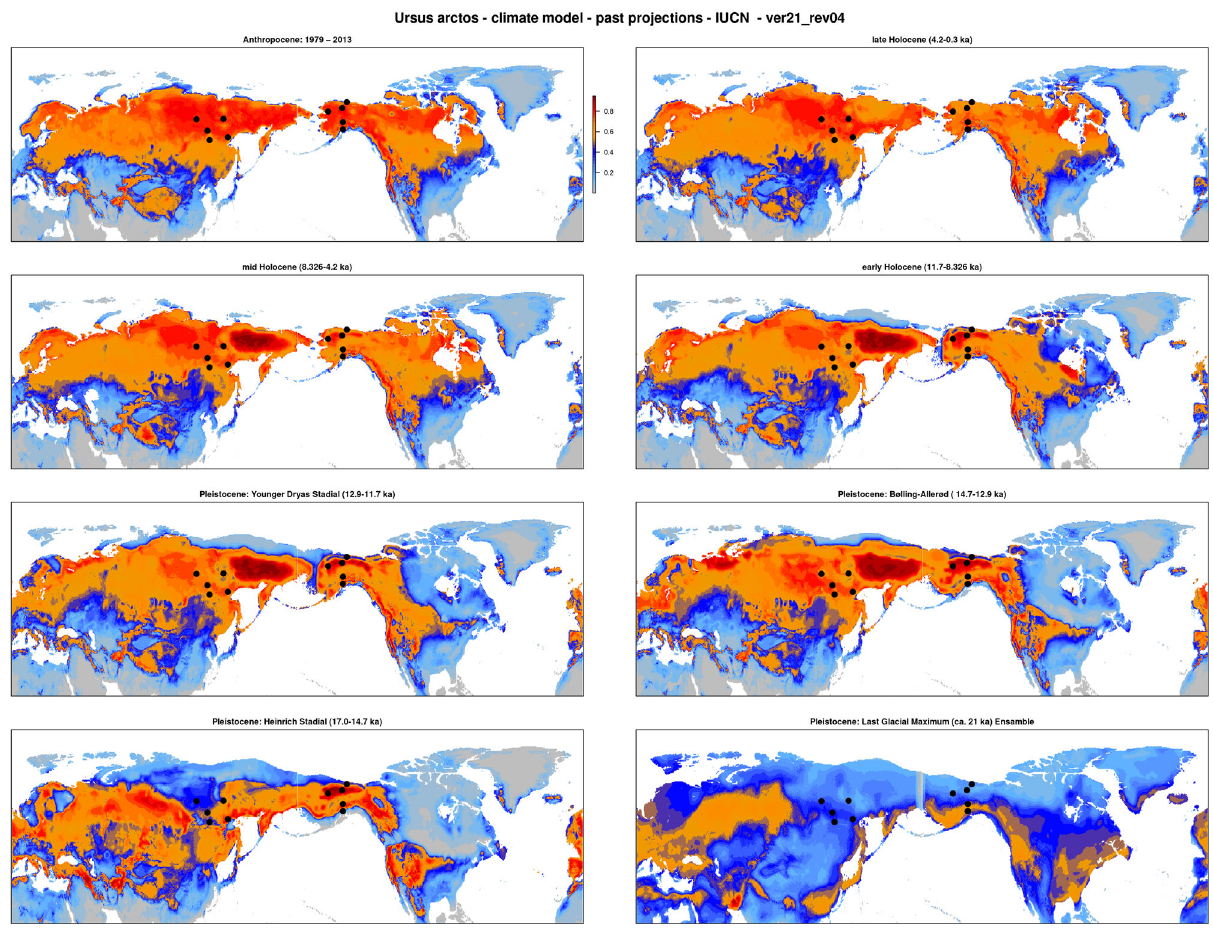
Fig. 3 Climate suitability modelling indicates that brown bears were absent from interior Alaska and eastern Siberia during the Last Glacial Maximum. Climate suitability projections on brown bear climatic suitability ranges for various time periods suggest that the species range of brown bear has remained relatively stable (at least in Eurasia) for nearly 20ky, including during stadials. In contrast, the projection for the brown bear range during the Last Glacial Maximum differs markedly from the present-day species range, especially with regard to climatic suitability in eastern Siberia. Note that these maps show climatic suitability only. Not considered are potential additional limitations caused by biotic factors (e.g., vegetation), abiotic factors (e.g., ice cover) and migration barriers. Black dots indicate the geographic location of samples of populations which are marked by f3-analyses as admixed ( ‘ Yakutia ’ and ‘ Alaska ’ , see Fig. 4a,